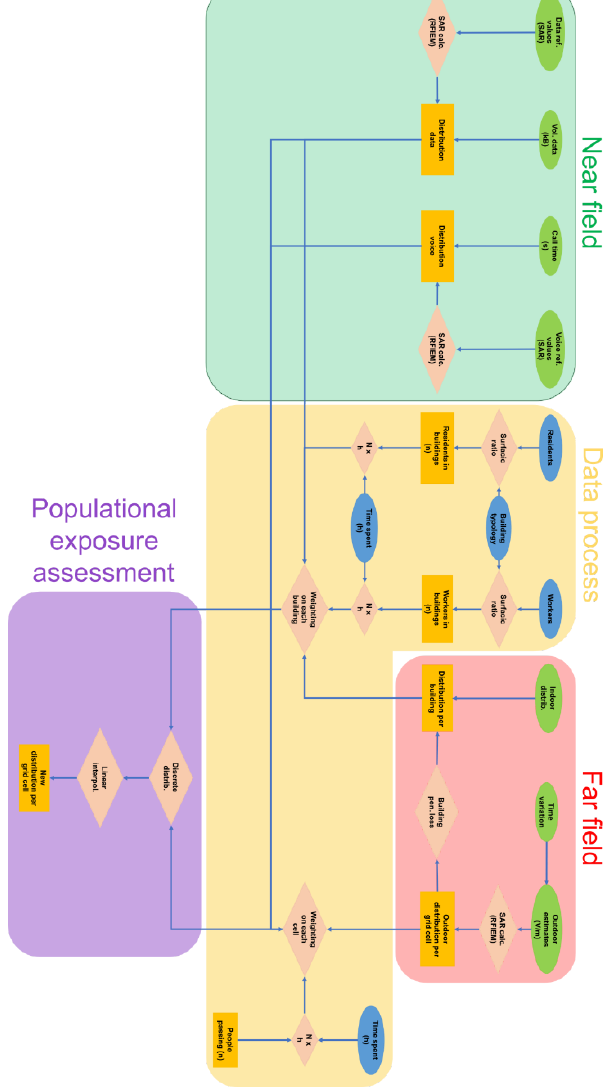
Figure 1. Exposure assessment framework. Colored boxes depict methodological processes that are described hereafter: far-field exposure assessment in red, near-field exposure assessment in green, data fusion of geospatial data in yellow, and populational exposure assessment in purple.